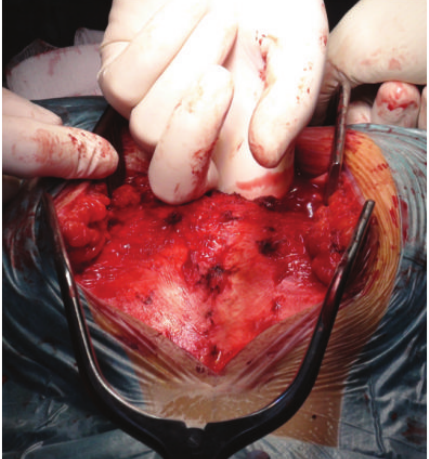
Figure 5: Initial finger dissection used to mobilize the rectum.